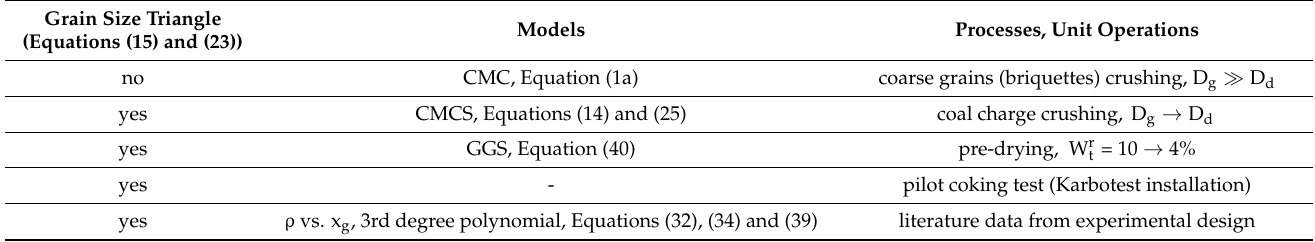
Table 1. Models describing the grain